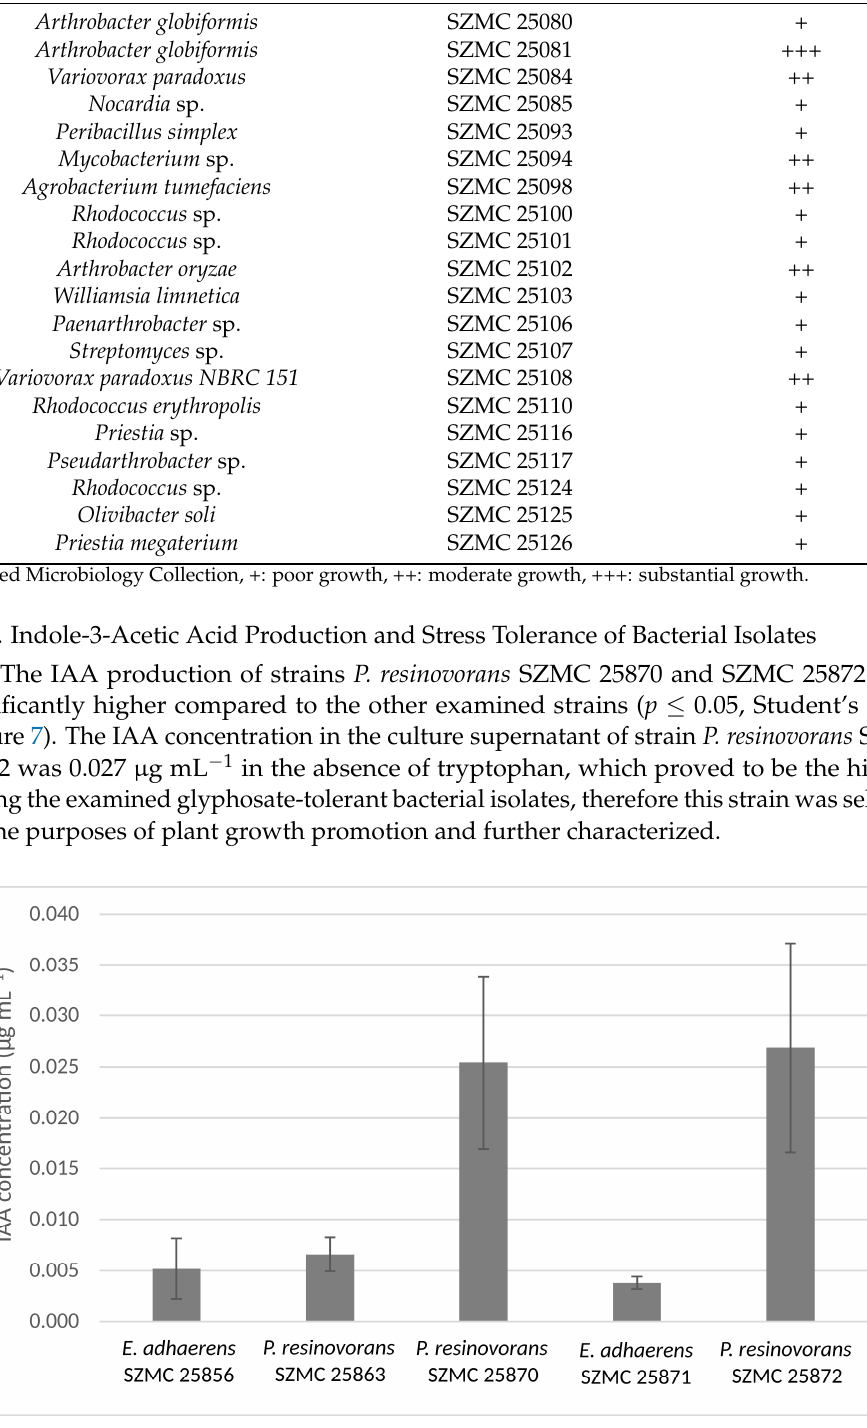
Figure 7. Indole-3-acetic acid (IAA) production of potential plant growth promoting glyphosate- tolerant bacterial strains measurep by HPLC (mean ± SD). We tested the tolerance of strain P. resinovorans SZMC 25872 to stress factors. The favorable pH range of this strain was found in the neutral and slightly alkaline range between 7.00 and 8.36. Assays for tolerance to adverse abiotic factors revealed that